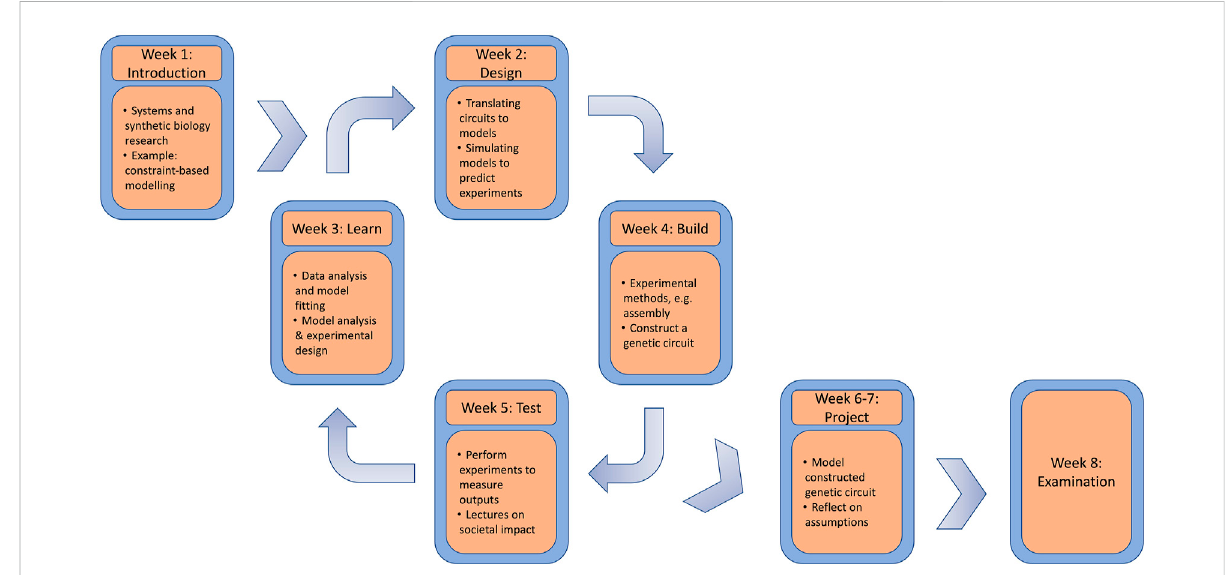
FIGURE 2 Course overview and relation to DBTL cycle. Whilst we do not explicitly follow the DBTL cycle in chronological order, we divide our teaching weeks into the four categories. After an introduction week, the DBTL cycle begins to show students how modelling and experimental synthetic biology can be combined. Later weeks then require students to write a report critically re fl ecting on their research, before a fi nal exam tests the students on the knowledge they have